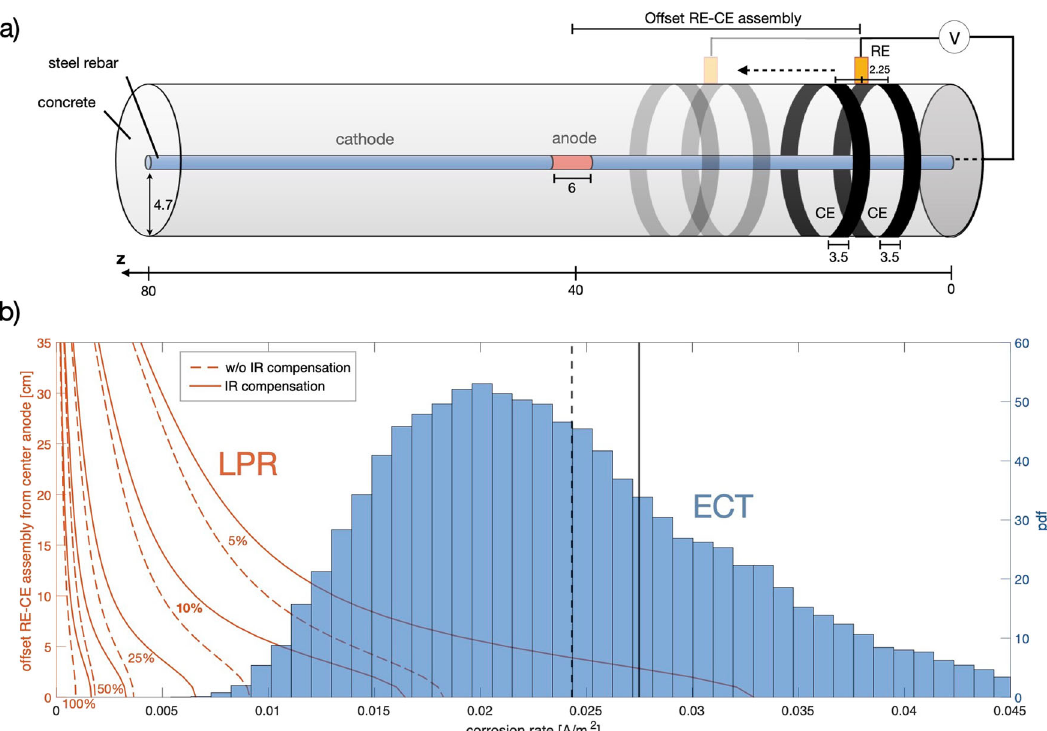
Fig. 6 Comparison of ECT to the traditional LPR method. a Overview of the setup of the modelled LPR method, with depicted distances in [cm]. Counter electrodes (CE) are placed adjacent to the reference electrode (RE). Corrosion rates are obtained for different positions of the RE- CE assembly over the concrete surface. b The blue histogram shows the probability density function estimate of the sampled corrosion current densities, corresponding to every set of model parameters sampled during the MCMC. The black line represents the corrosion rate corresponding to the known ground truth model parameters, the dashed black line the mean of the sampled corrosion rates, as obtained from ECT. The red curves represent the corrosion rates obtained by the modelled LPR technique, as a function of position of the RE-CE assembly and for different assumed corroding steel areas [% of the total steel area], with and without IR compensation.